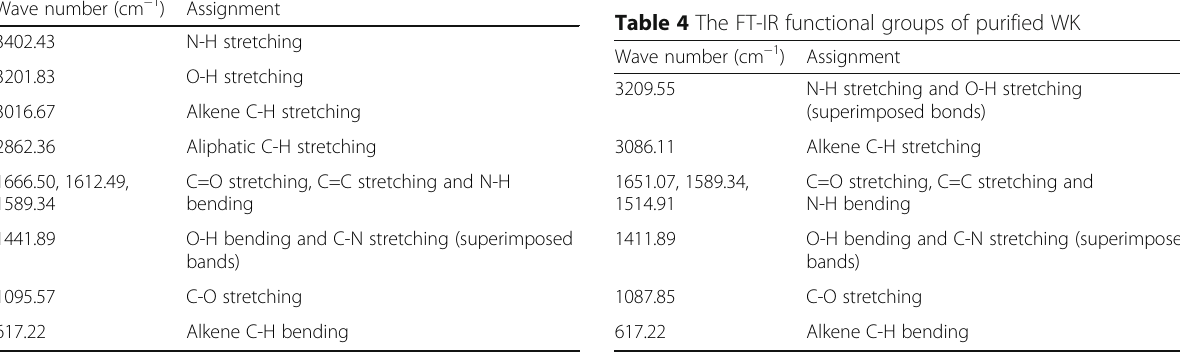
Table 3 The FT-IR functional groups of purified TK